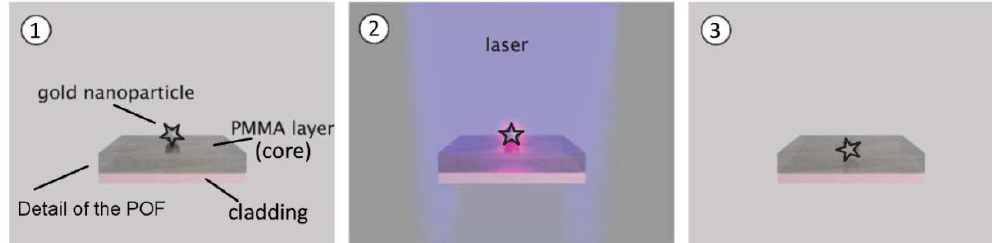
Figure 2. Scheme of immobilization steps: before (1), during (2), and after (3) laser irradiation.